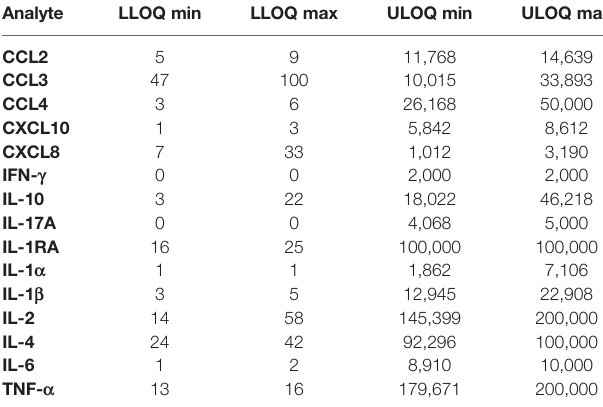
TABLE 2 | Limits of quanti fi cation (in